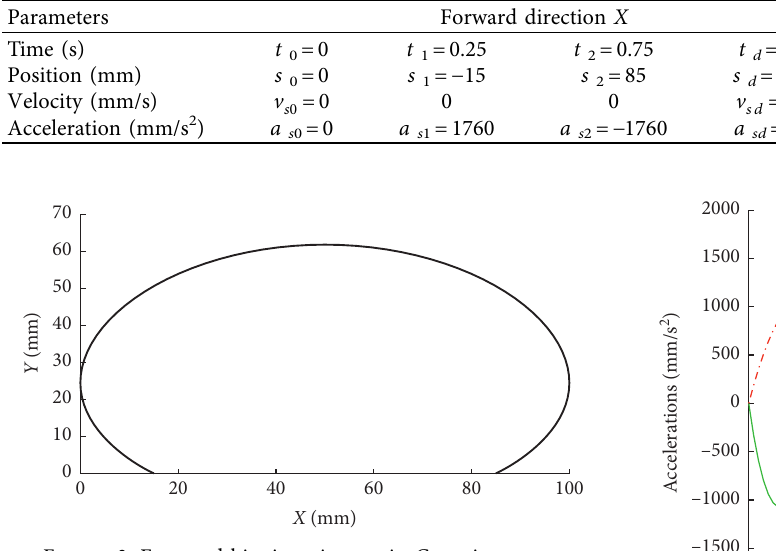
Figure 3: Foot-end bionic trajectory in Cartesian space.